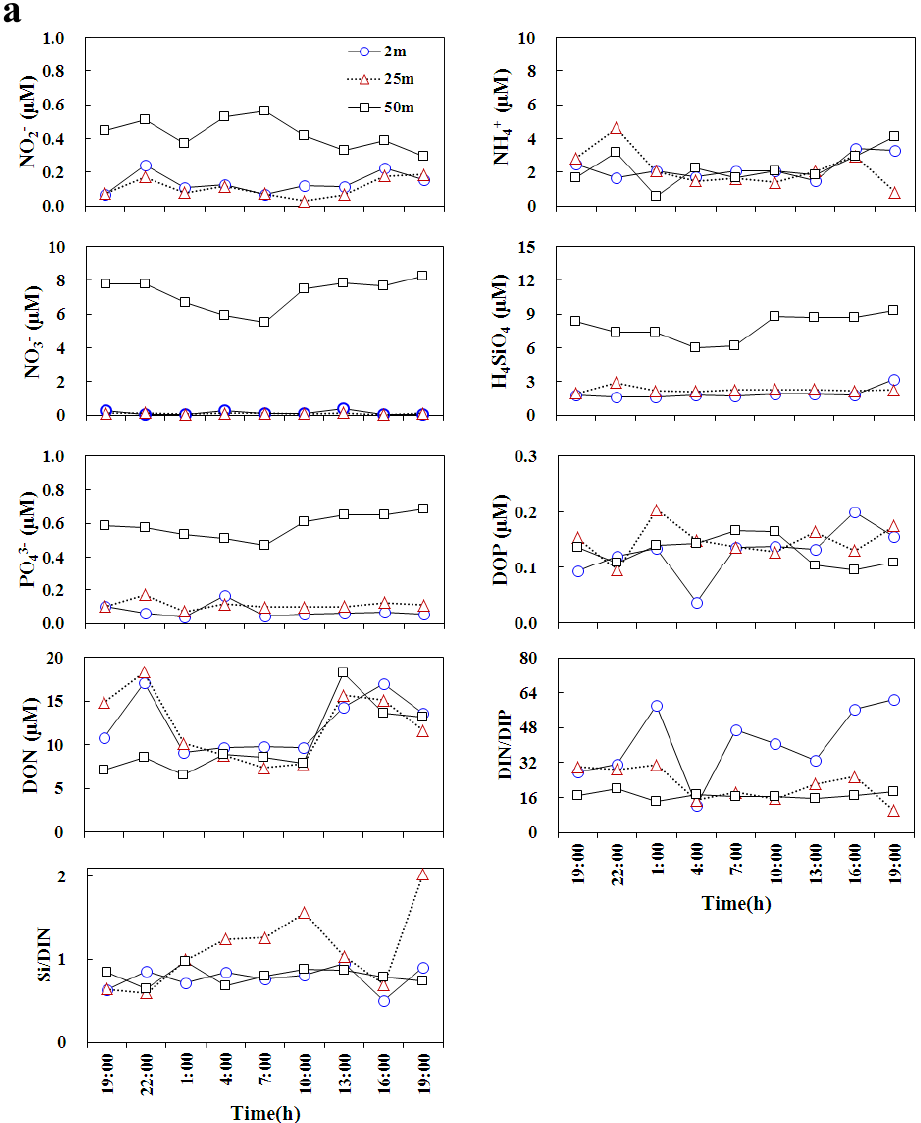
Figure 4 The concentrations of nutrients ( μ M) at anchor station (a) T2-3 in August 2007, (b) station T2-2 in July 2008 and (c) station 15# in July 2009. The tide heights (cm) during July 2008 and July 2009 are provided and the red circle represents the sampling time. No data on tidal variation were available during August 2007, and consequently the tide height is not showed.